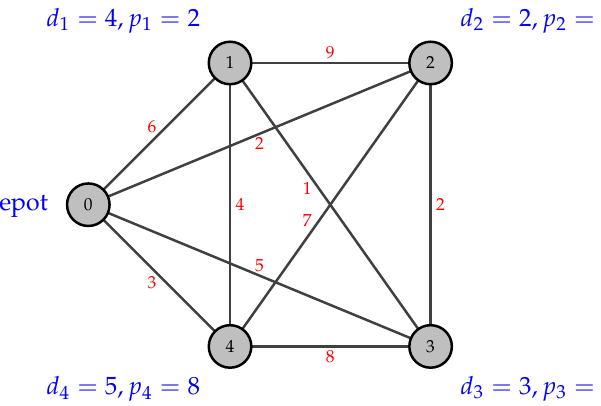
Figure 1. Running example with 4 customers and the depot. Pickup and delivery demands are marked in blue, and distances between customers are marked in red.